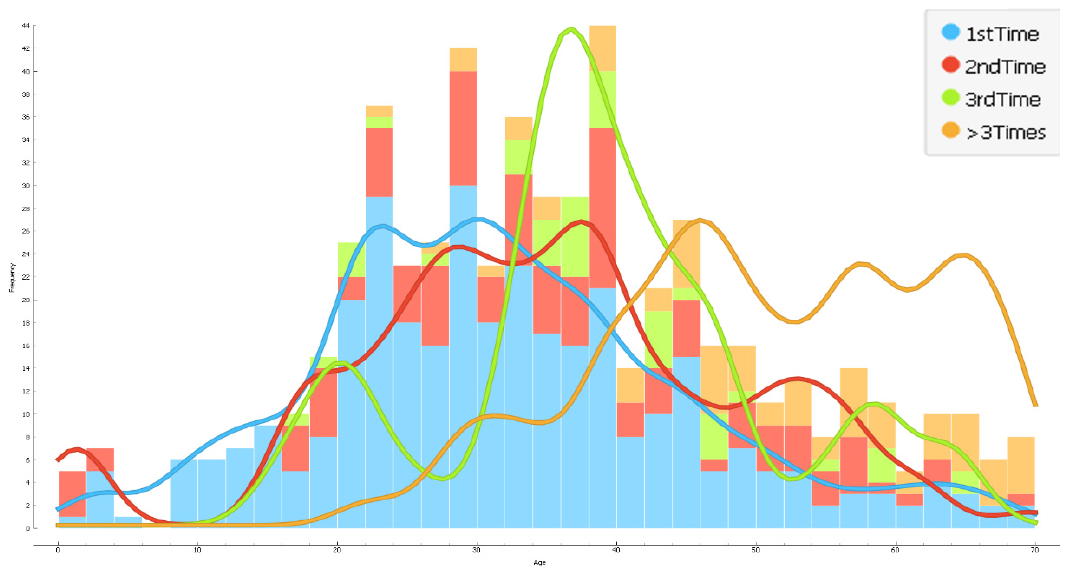
Figure 5. Repetition of disease among age groups for the 1st, 2nd, 3rd, and beyond.